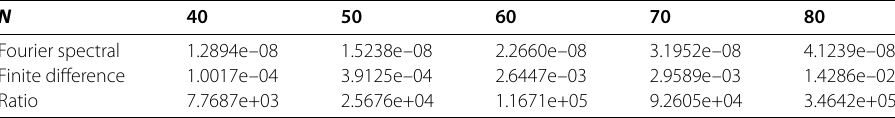
Table 1 The relative error for fractional diffusion equation for various values of discretization, at D = 0.25 and t = 5 N 40 50 60 70 80 Fourier spectral 1.2894e–08 1.5238e–08 2.2660e–08 3.1952e–08 4.1239e–08 Finite difference 1.0017e–04 3.9125e–04